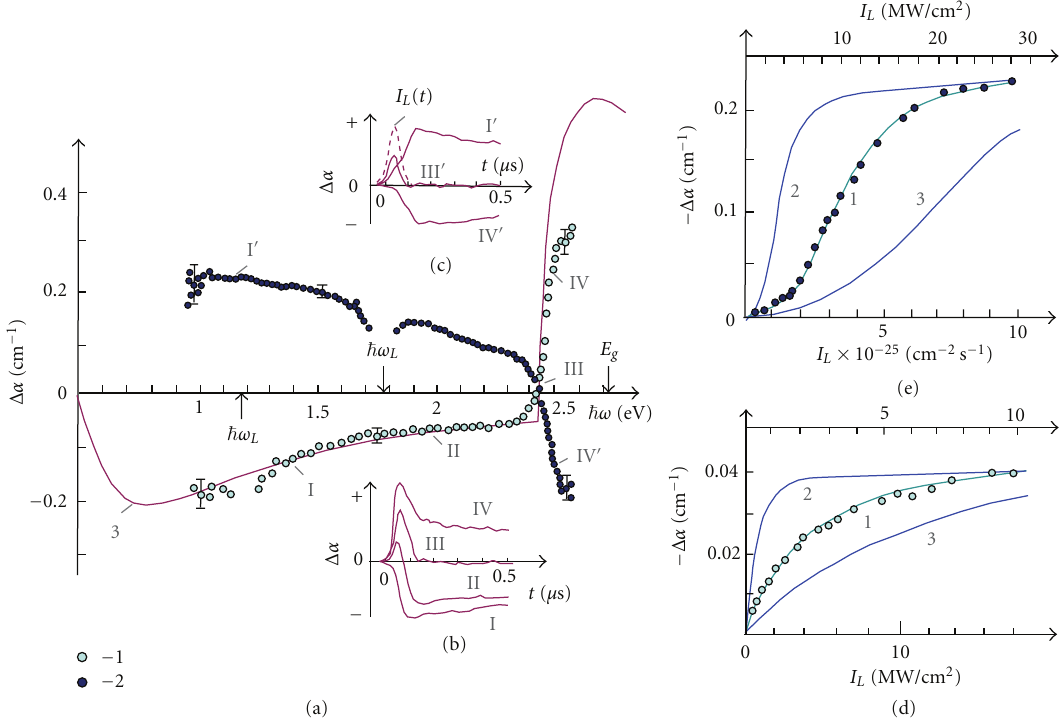
Figure 11: Spectra (a), signals (b) and (c) and dependences on modulation intensity (d) and (e) of the induced absorption of σ -DLSS and γ -DLSS type in ZnSe. The conditions of laser modulation are (cid:2) ω L = 1 . 17 eV < 1/2 E g (a1), (b), (d) and (cid:2) ω L = 1 . 78 eV > 1/2 E g (a2), (c), (e); Δ t = 30 ns; E = 2 . 72 eV, from L g